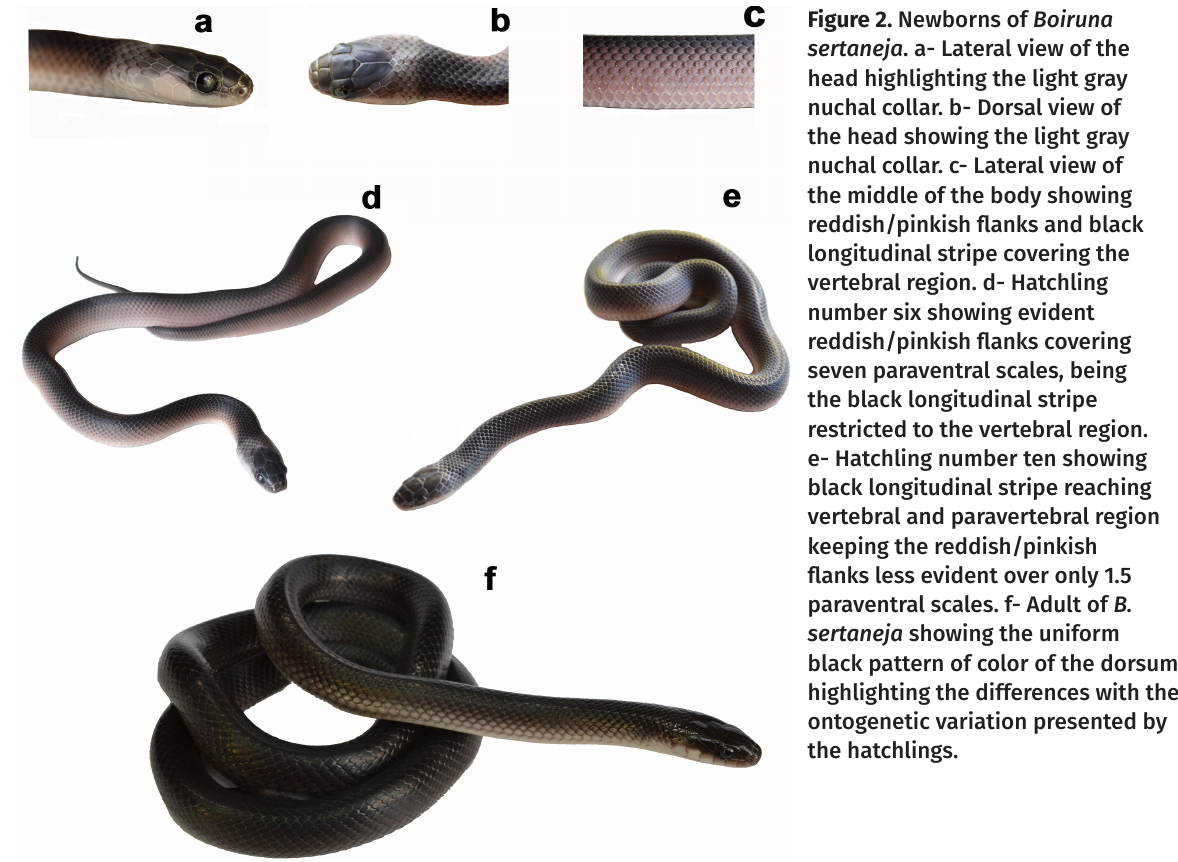
Figure 2. Newborns of Boiruna sertaneja . a- Lateral view of the head highlighting the light gray nuchal collar. b- Dorsal view of the head showing the light gray nuchal collar. c- Lateral view of the middle of the body showing reddish/pinkish flanks and black longitudinal stripe covering the vertebral region. d- Hatchling number six showing evident reddish/pinkish flanks covering seven paraventral scales, being the black longitudinal stripe restricted to the vertebral region. e- Hatchling number ten showing black longitudinal stripe reaching vertebral and paravertebral region keeping the reddish/pinkish flanks less evident over only 1.5 paraventral scales. f- Adult of B. sertaneja showing the uniform black pattern of color of the dorsum highlighting the differences with the ontogenetic variation presented by the